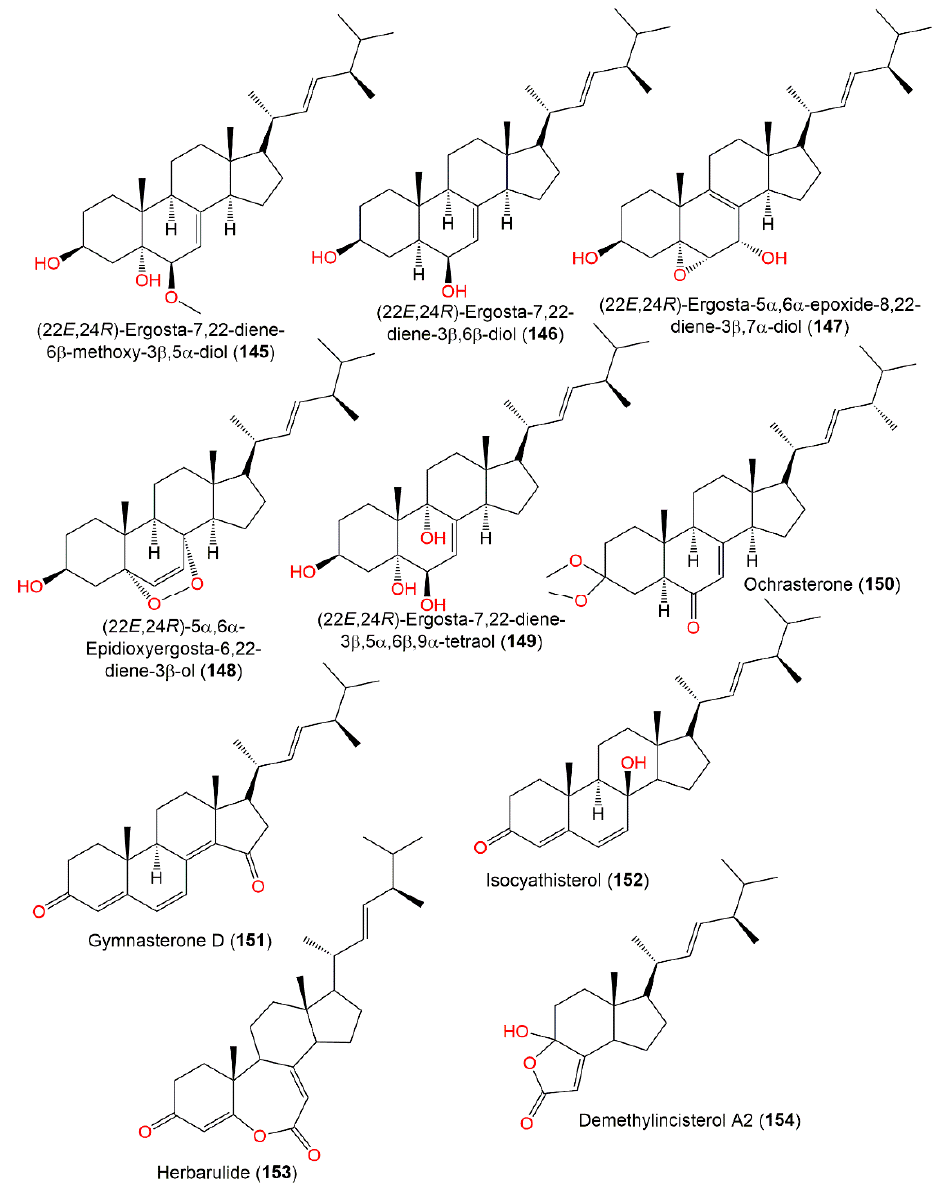
Figure 14. Sterols ( 145 – 154 ) reported from A.